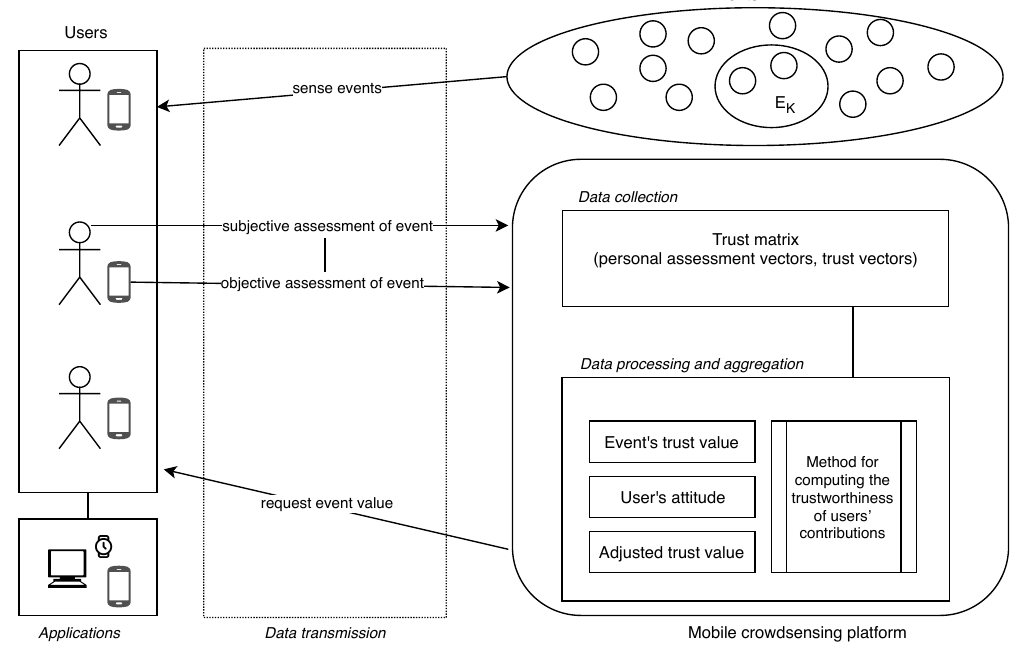
Figure 1. Trust framework